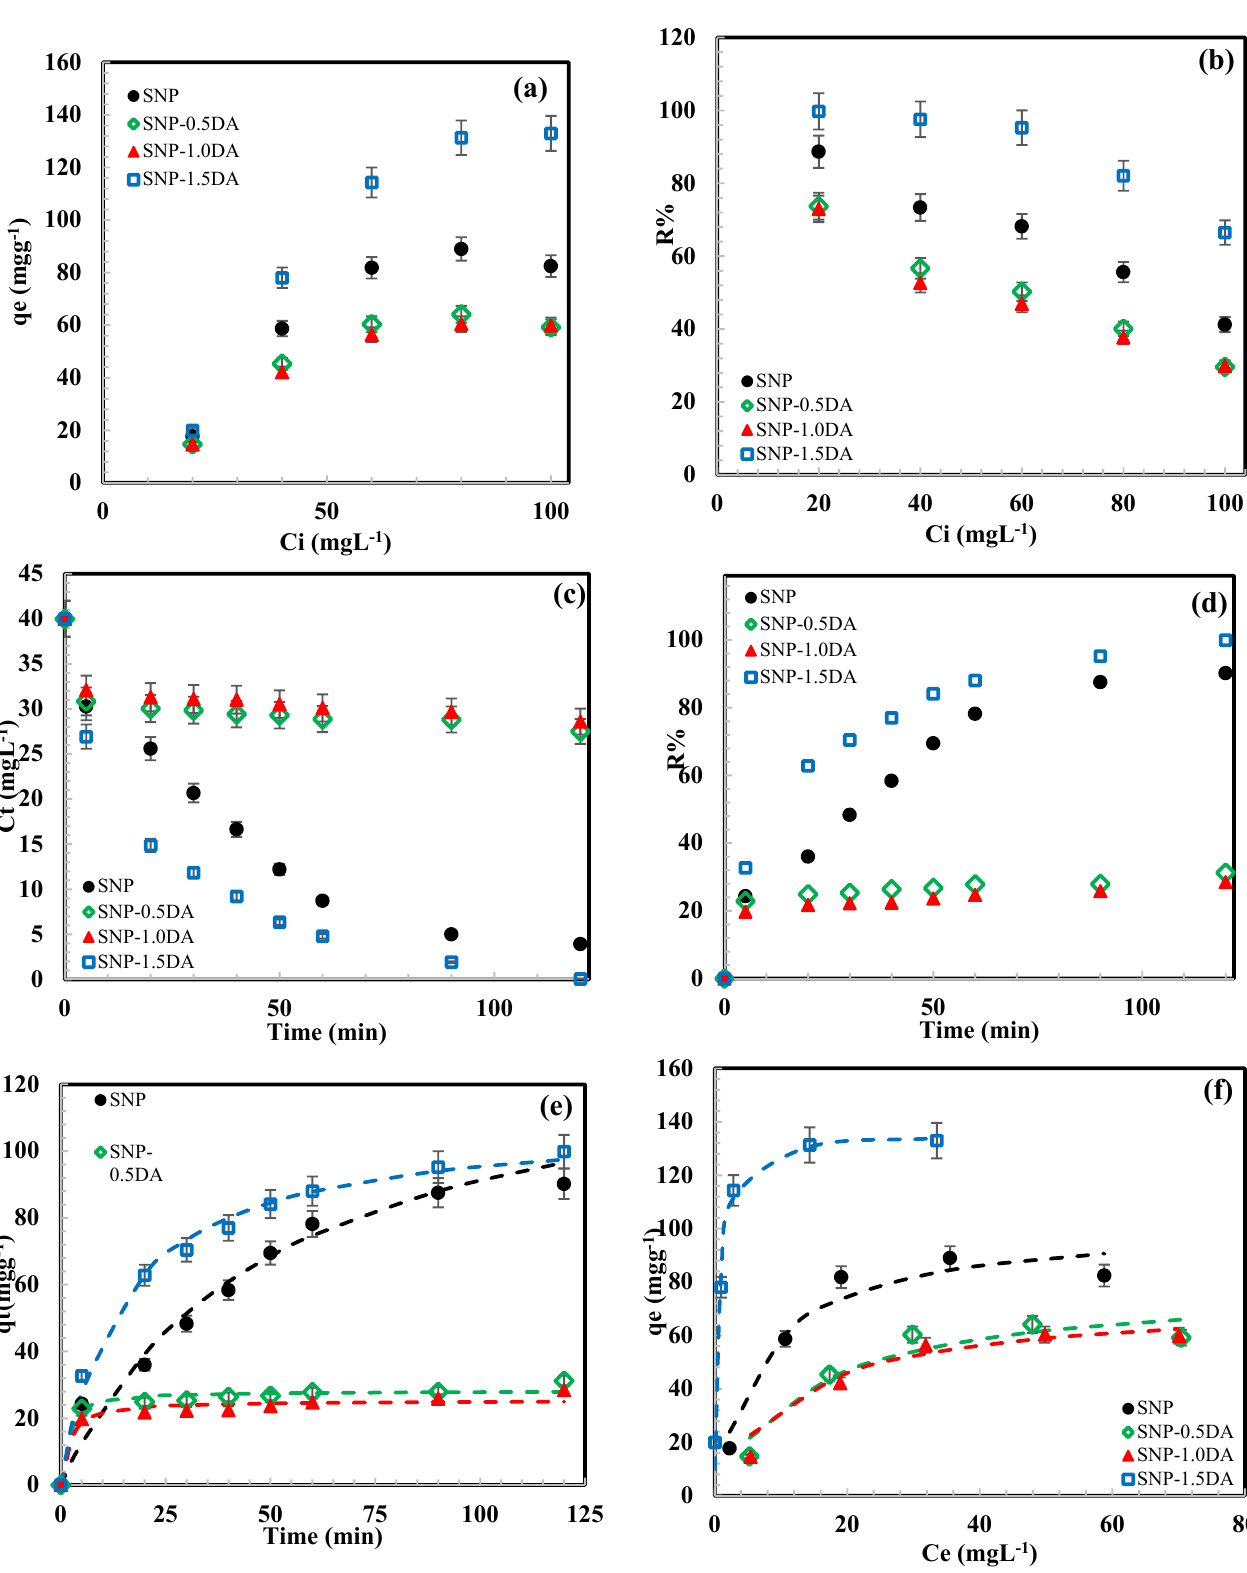
Figure 8. The dependence of equilibrium adsorption capacity on Zn +2 initial concentration ( a ), removal efficiency on Zn +2 initial concentration ( b ), Zn +2 concentration on time ( c ), equilibrium adsorption capacity on Zn +2 equilibrium concentration ( d ), adsorption capacity on time ( e ) and removal efficiency on time ( f ). Table 3. The Langmuir adsorption isotherm model parameters and the pseudo-second-order kinetic model parameters for the prepared samples.